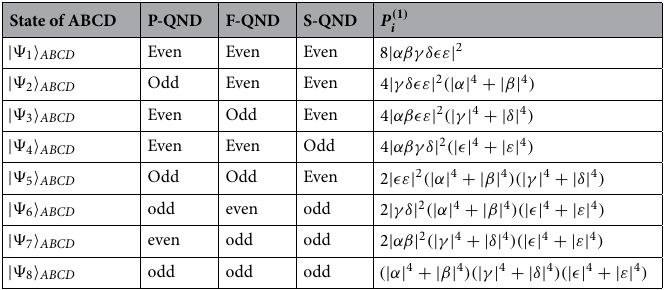
Table 1. The relation between the states of four photons, the parity check measurement results and the